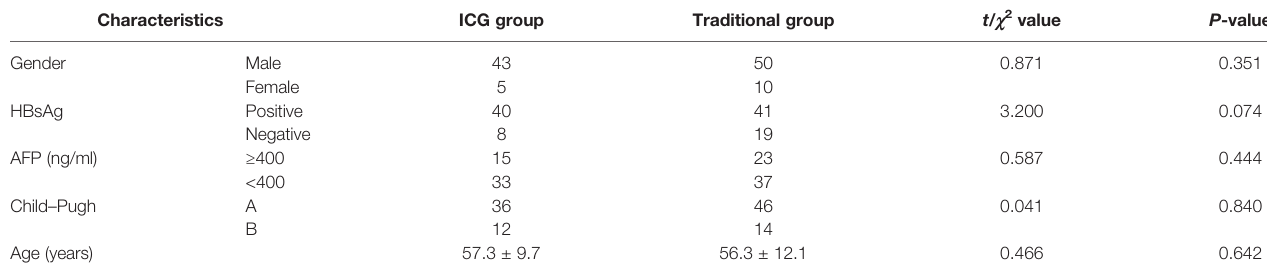
TABLE 1 | Preoperative clinical features between the ICG-guided and traditional groups. Characteristics